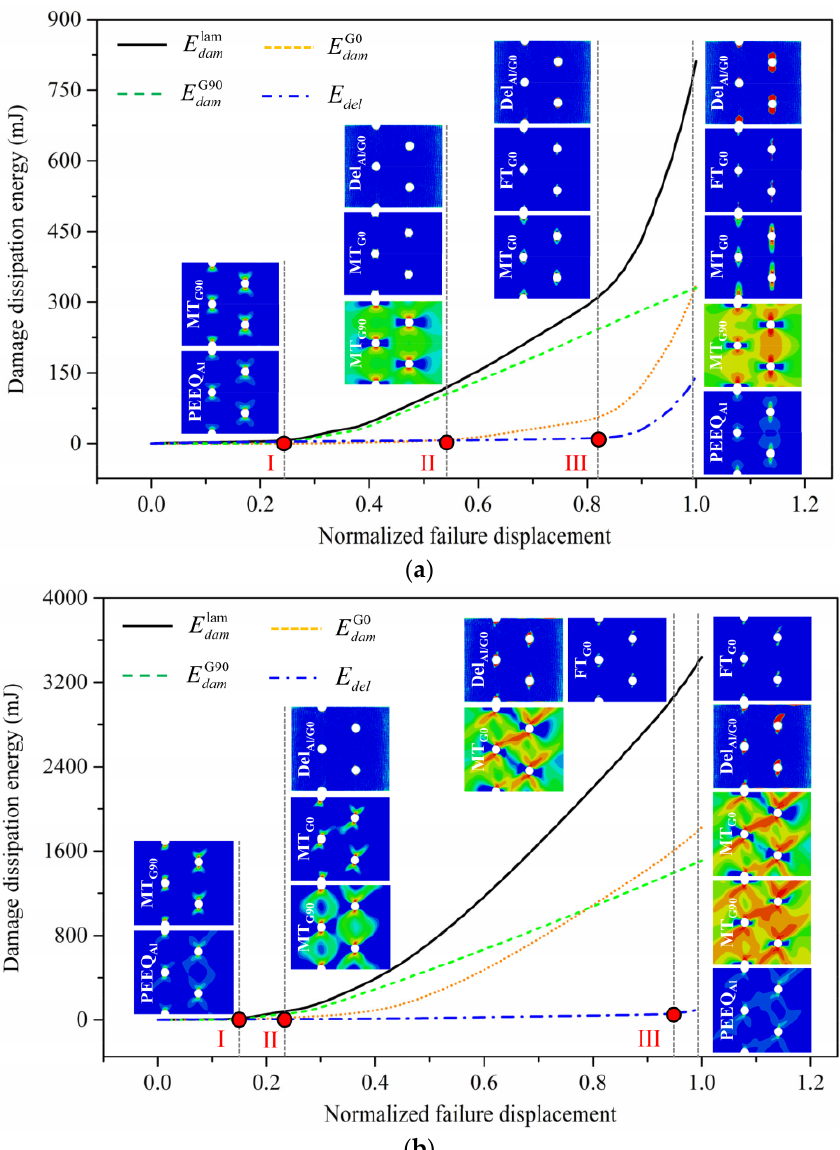
Figure 16. Damage evolution characterization of H5R2S specimen, employing the energy dissipation approach: ( a ) On-axis; ( b ) Off-axis.